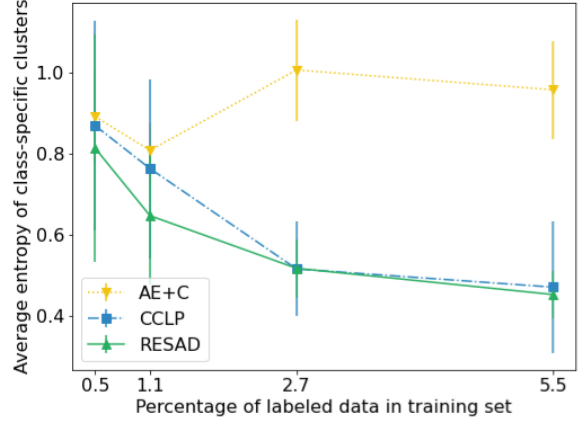
Figure 5. This figure shows the purity of the class-specific clusters in the latent space. The lower values indicate purer